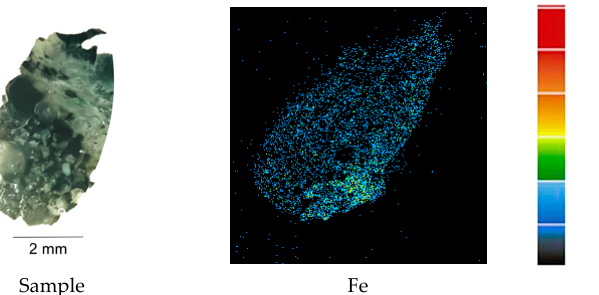
Figure 2. µ-PIXE elemental distribution in sample HV-11 for elements Si, Al, Ca, K and Fe. The two maps on top row have dimensions of 2.25 × 2.25 mm 2 and were obtained with a 0.7 MeV proton beam and the remaining maps have dimensions of 2.64 × 2.64 mm 2 and were obtained with a 2 MeV proton beam.